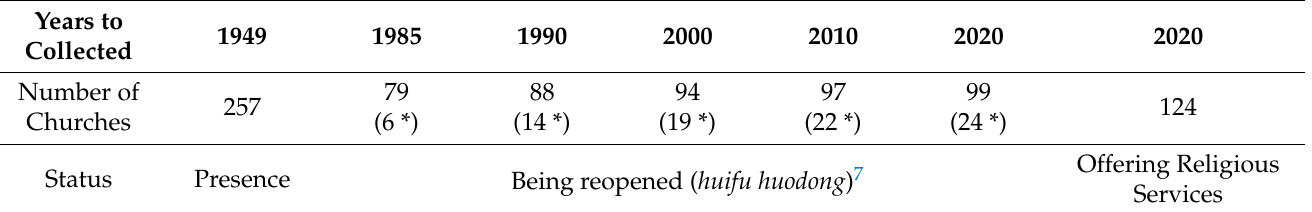
Table 1. The Status of Catholic Churches in Sichuan from 1949 to